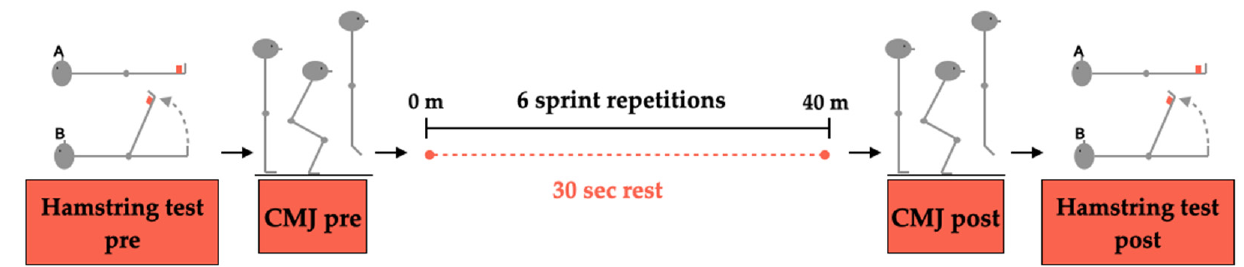
Figure 1. Outline of the protocol procedure. A: Initial position; B: Final position